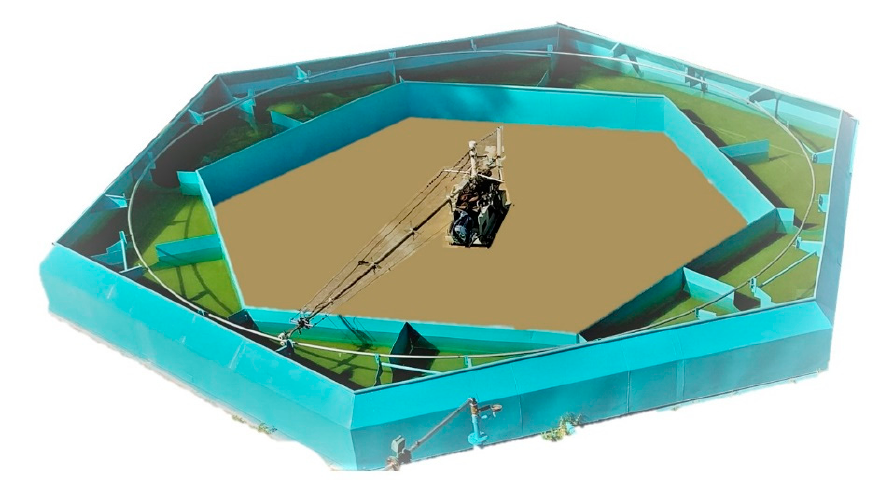
Figure 5. The 10 m diameter tow pool facility used for the marine ramjet research.